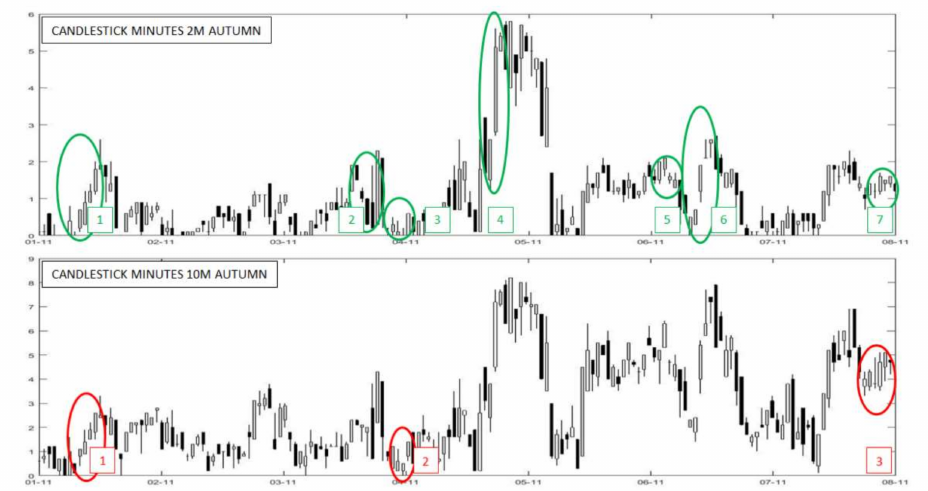
Figure 4. Candlestick chart for Los Montes del Cierzo, hourly resolution, first week of November 2016, at 2 m ( top ) and 10 m ( bottom ) above the ground.